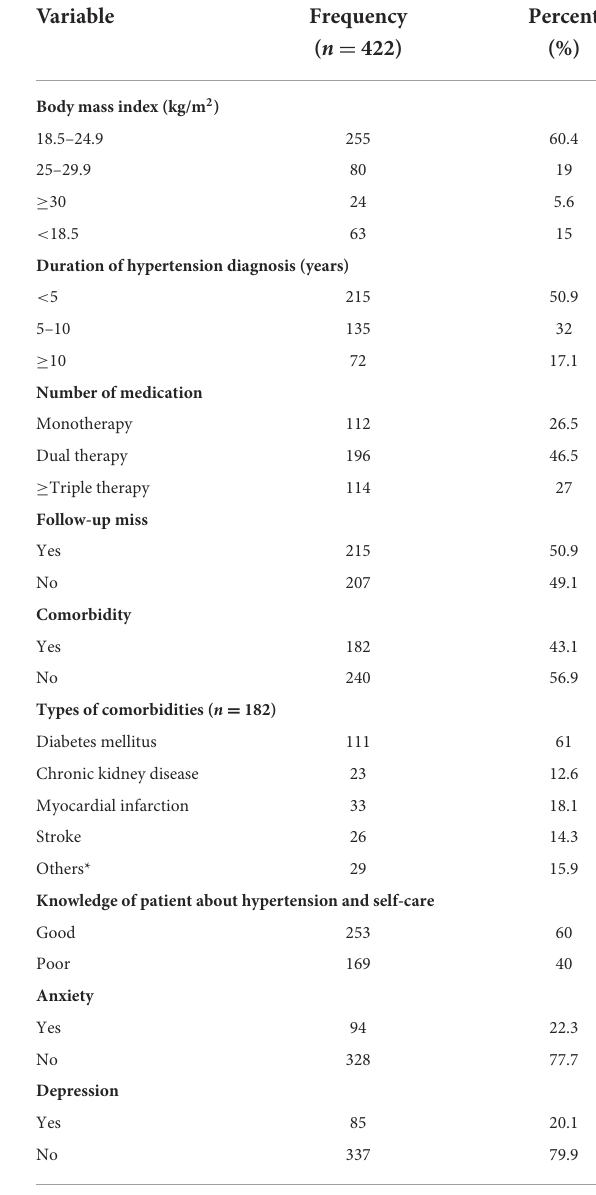
TABLE 2 Patient and clinical characteristics of hypertensive patients on follow-up at public Hospitals in the Harari regional state and Dire Dawa City administration, Eastern Ethiopia, 2022 (n =